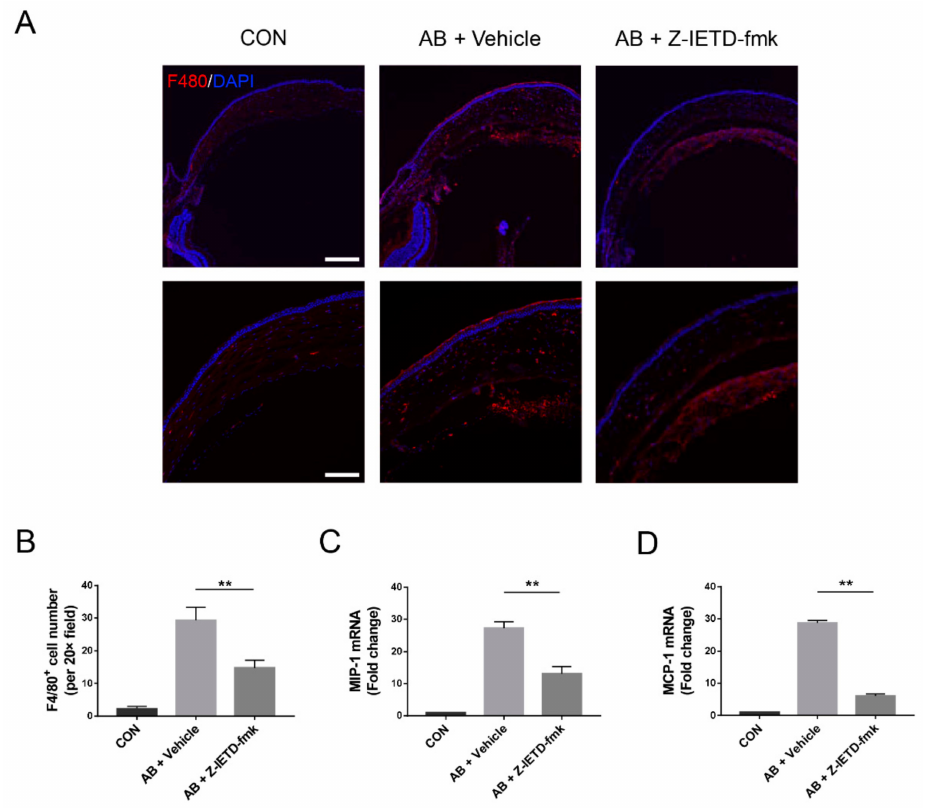
Figure 5. Pharmacological inhibition of caspase-8 suppressed macrophage recruitment. ( A ) Representative immunofluorescence micrographs of F4 / 80 staining. Scale bars: 200 µ m (upper, 10 × field), 100 µ m (lower, 20 × field). ( B ) Statistical analysis of F4 / 80-positive cell number ( n = 5). ( C , D ) RT-qPCR analysis of MIP-1 and MCP-1 mRNA expression in corneas ( n = 3). The data are presented as the mean ± SD. ** p <